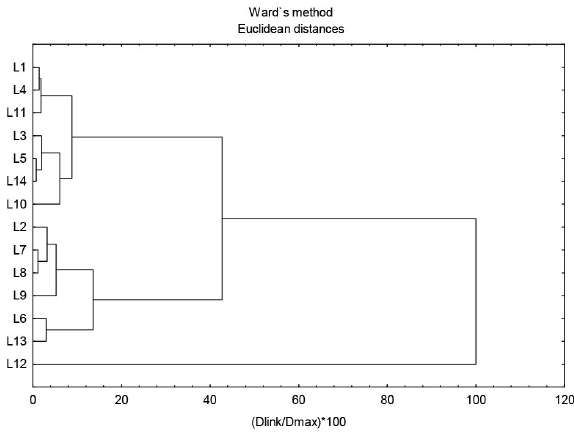
Figure 3. The dendrogram of the cluster analysis of